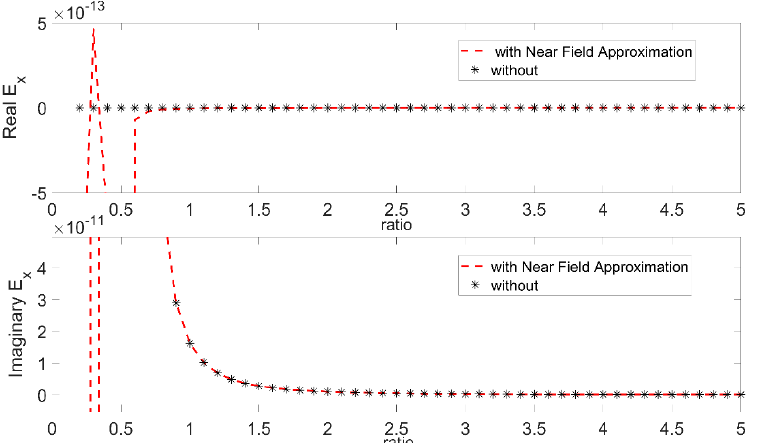
Figure 6. Comparison of the real and imaginary parts of the electric field component E x versus the ratio of the measurement distance to the cable length, for the Segmented Cable Case (star marks) and the Segmented Cable Case with Near Field Approximation with N = 50 segments (dashed lines).